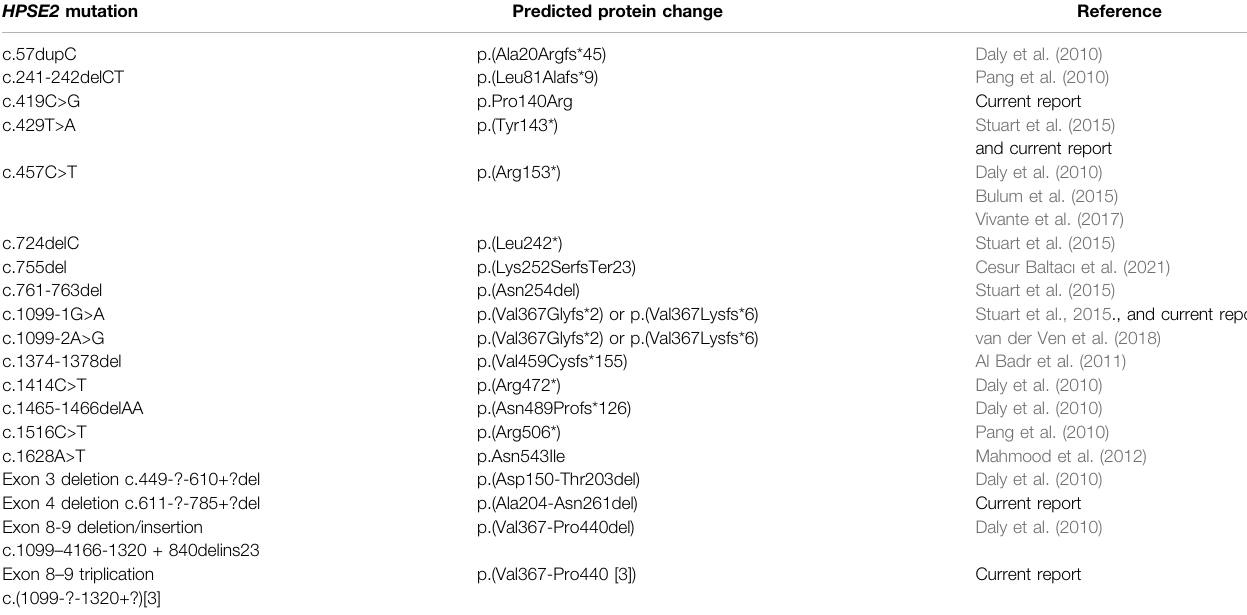
TABLE 1 | Summary of HPSE2 variants associated with UFS. The table contains both results from historical reports as well as the current